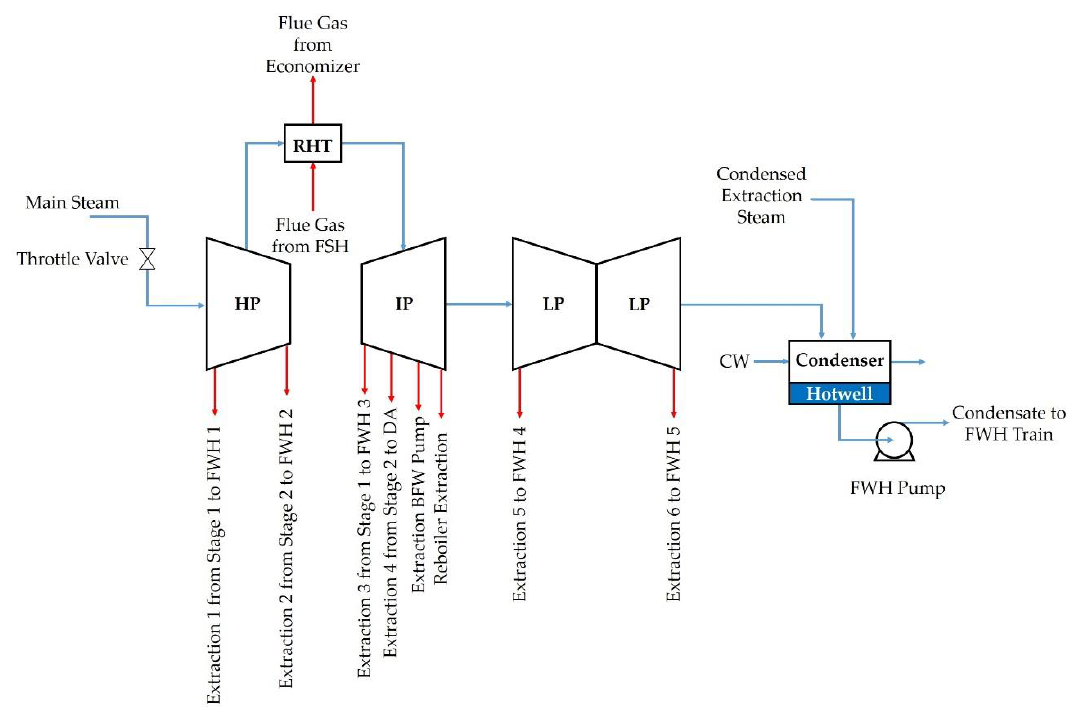
Figure 3. Turbine Section Block Flow Diagram.